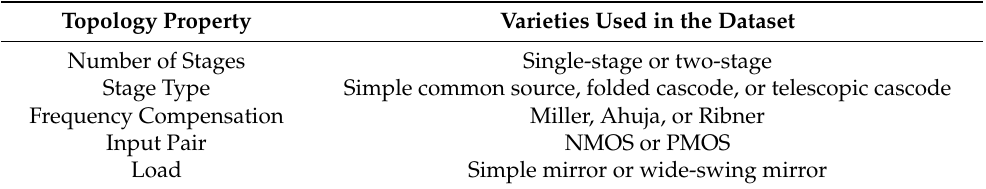
Table 1. The varieties in the circuit topologies forming the dataset for the training of the neural